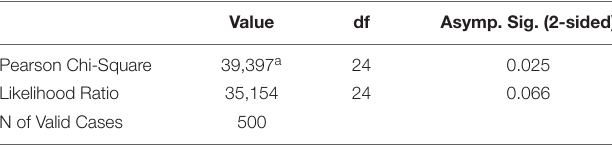
TABLE 4 | Summarizes the result of the Chi-square test values (respondents age and music production). Value df Asymp. Sig.